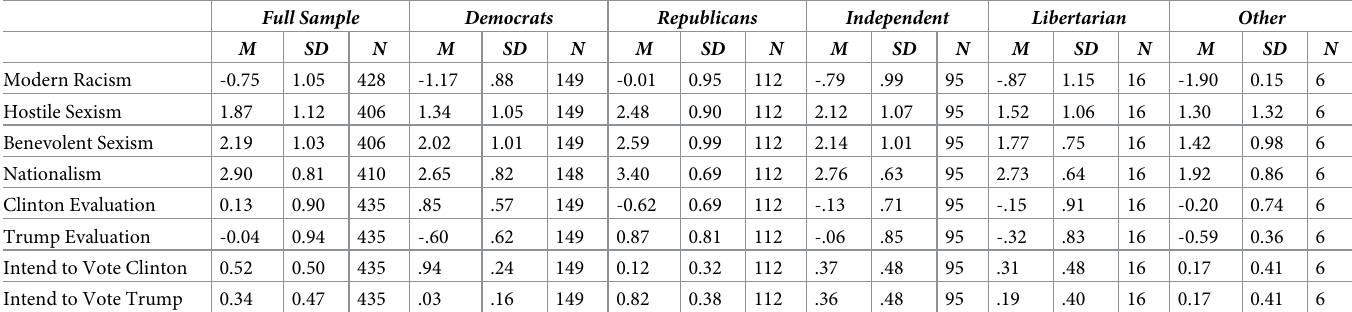
Table 1. Descriptive statistics for measures for participants who intended to vote at Time 1 for the full sample and split by political party.